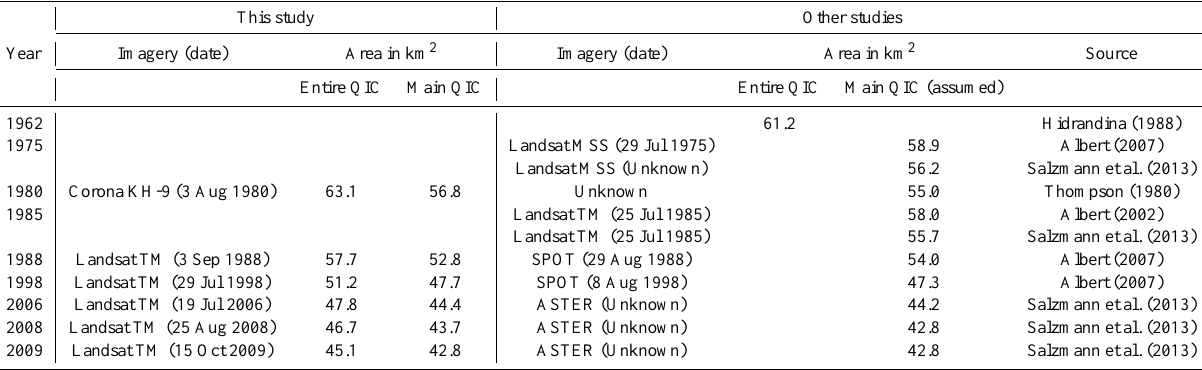
Table 5. Area measurements (including imagery used and date obtained) of the QIC from both this study and other studies. Entire QIC refers to all glacial regions identified in the earliest image, while main QIC refers to a subset of this, the largest continuous ice mass (cf. Fig. 8b). Our study has included the entire QIC area, i.e., all ice- and snow-covered regions that lie within the area of the earliest image (3 August 1980), and has captured smaller ice areas outside of the main QIC